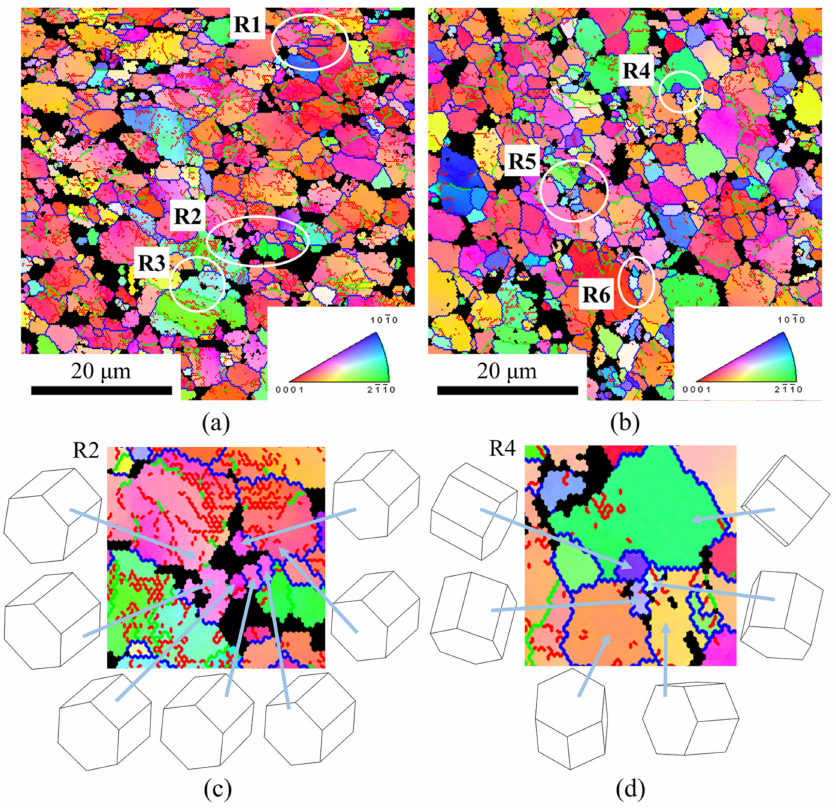
Figure 15. The IPF at different strains when deformed at 950 ◦ C and 0.01 s − 1 : ( a , c ) 0.3; ( b , d )